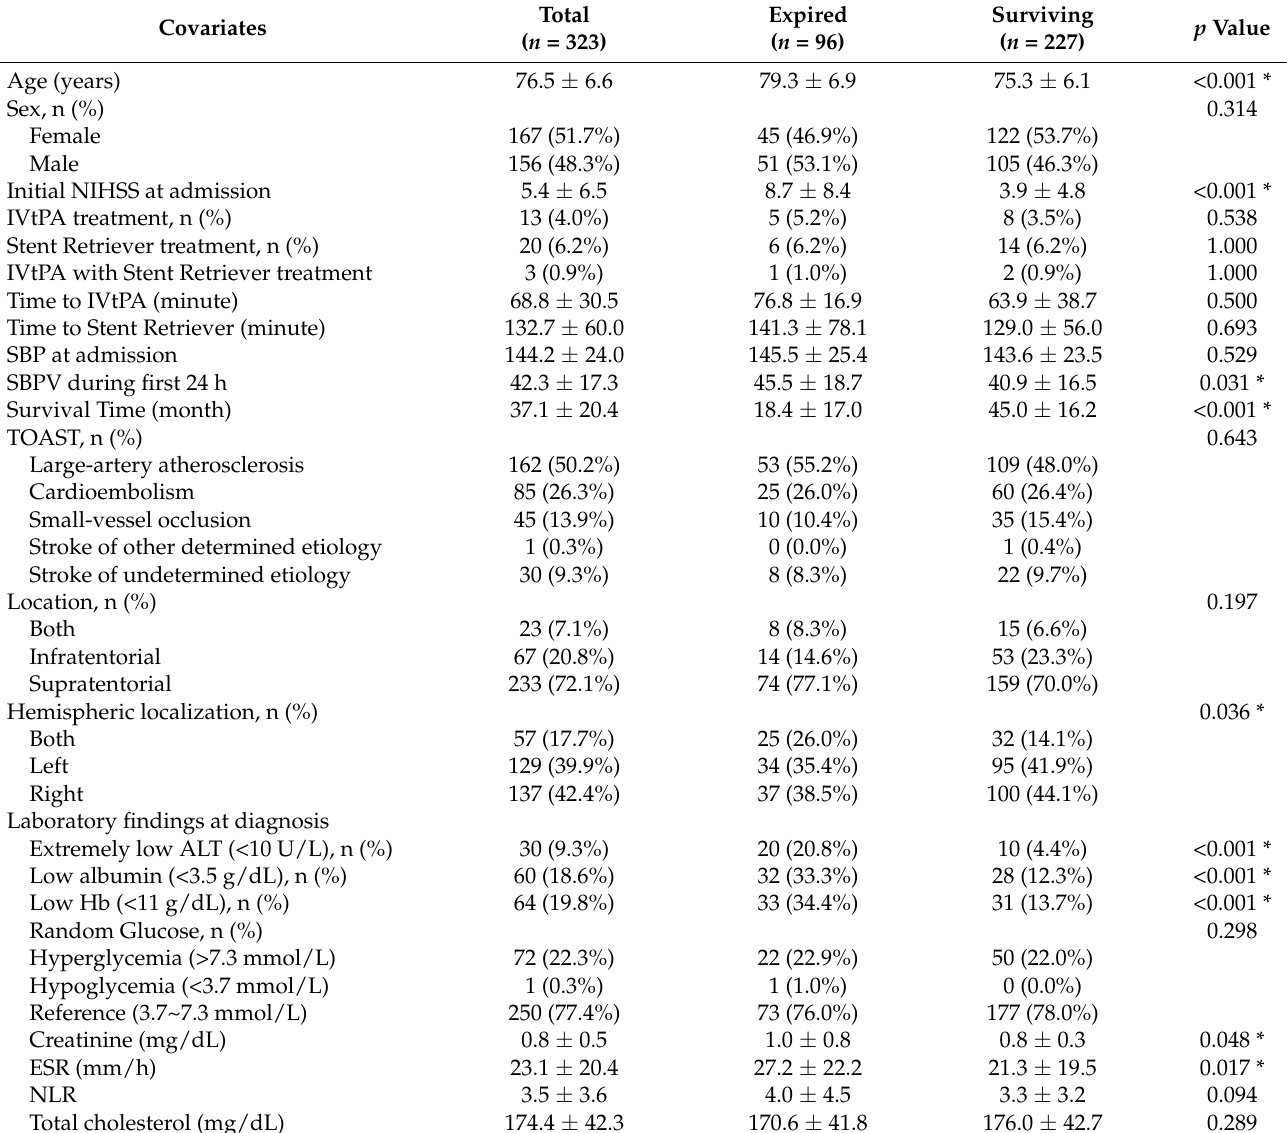
Table 1. General characteristics and comparison between expired and surviving